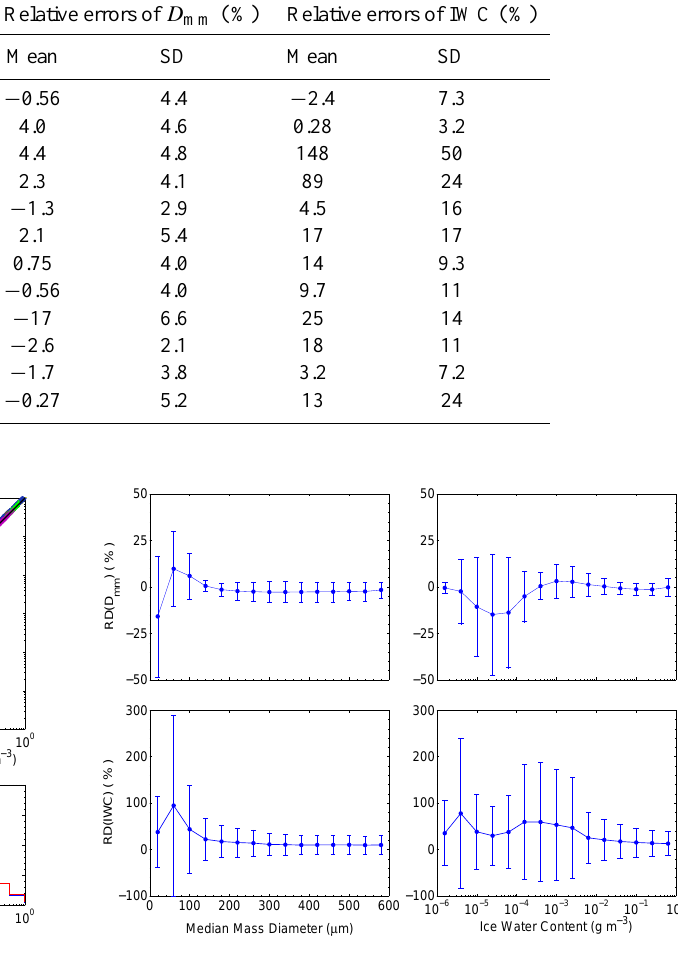
Figure 5. Relative differences (RD) of the calculated microphysical properties at different bins of median mass diameter (left panels) and ice water content (right panels). Error bars indicate the corre- sponding standard